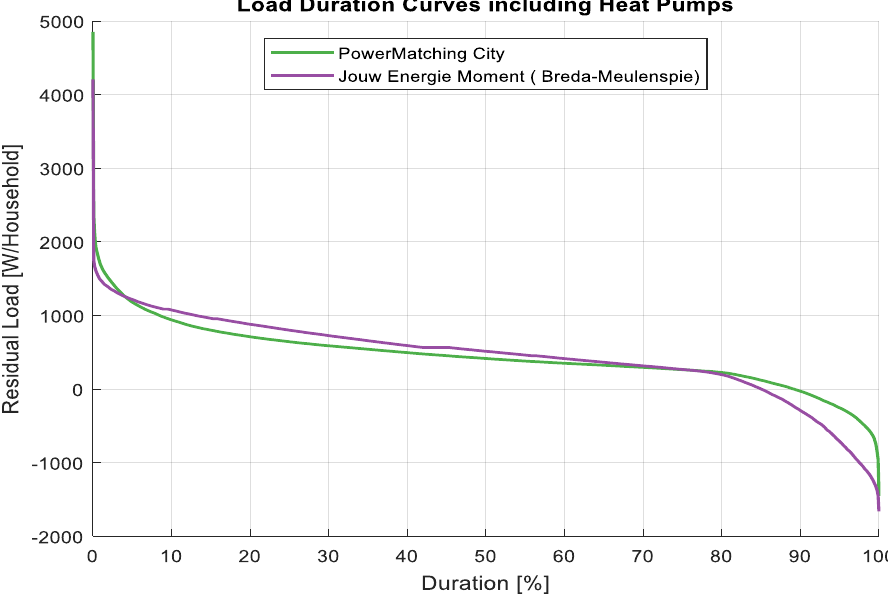
Figure 3. Load duration curves of the “PowerMatching City” project and “Jouw Energie Moment” project—the Meulenspie group (all households are equipped with heat pumps).